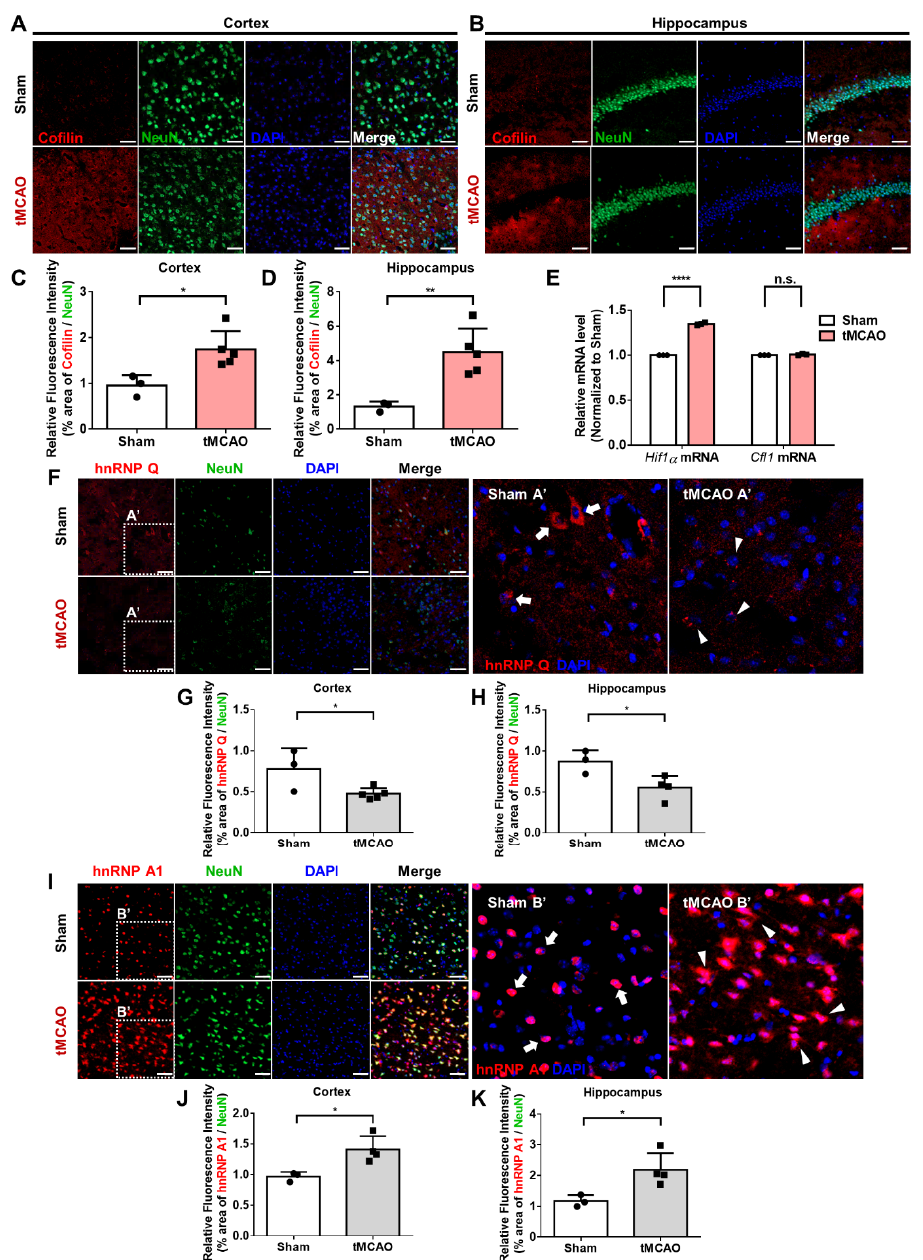
Figure 7. Expression and localization of hnRNP Q and hnRNP A1 in tMCAO mouse. ( A , B ) The immunofluorescence labeling of cofilin (red), DAPI (blue), and NeuN (green) in the cortex ( A ) and the hippocampus ( B ) of sham (top) or transiently middle artery occlusion (tMCAO) mouse (bottom). Scale bar = 50 μ M. ( C , D ) Quantification of relative fluorescence intensity of cofilin in the cortex ( C ) and the hippocampus ( D ) of sham mouse (white) or tMCAO mouse (pink), calculated by the area of intensity, which was normalized to the intensity of NeuN ( n = 5). ( E ) RT-qPCR analysis of Hif1 α mRNA or